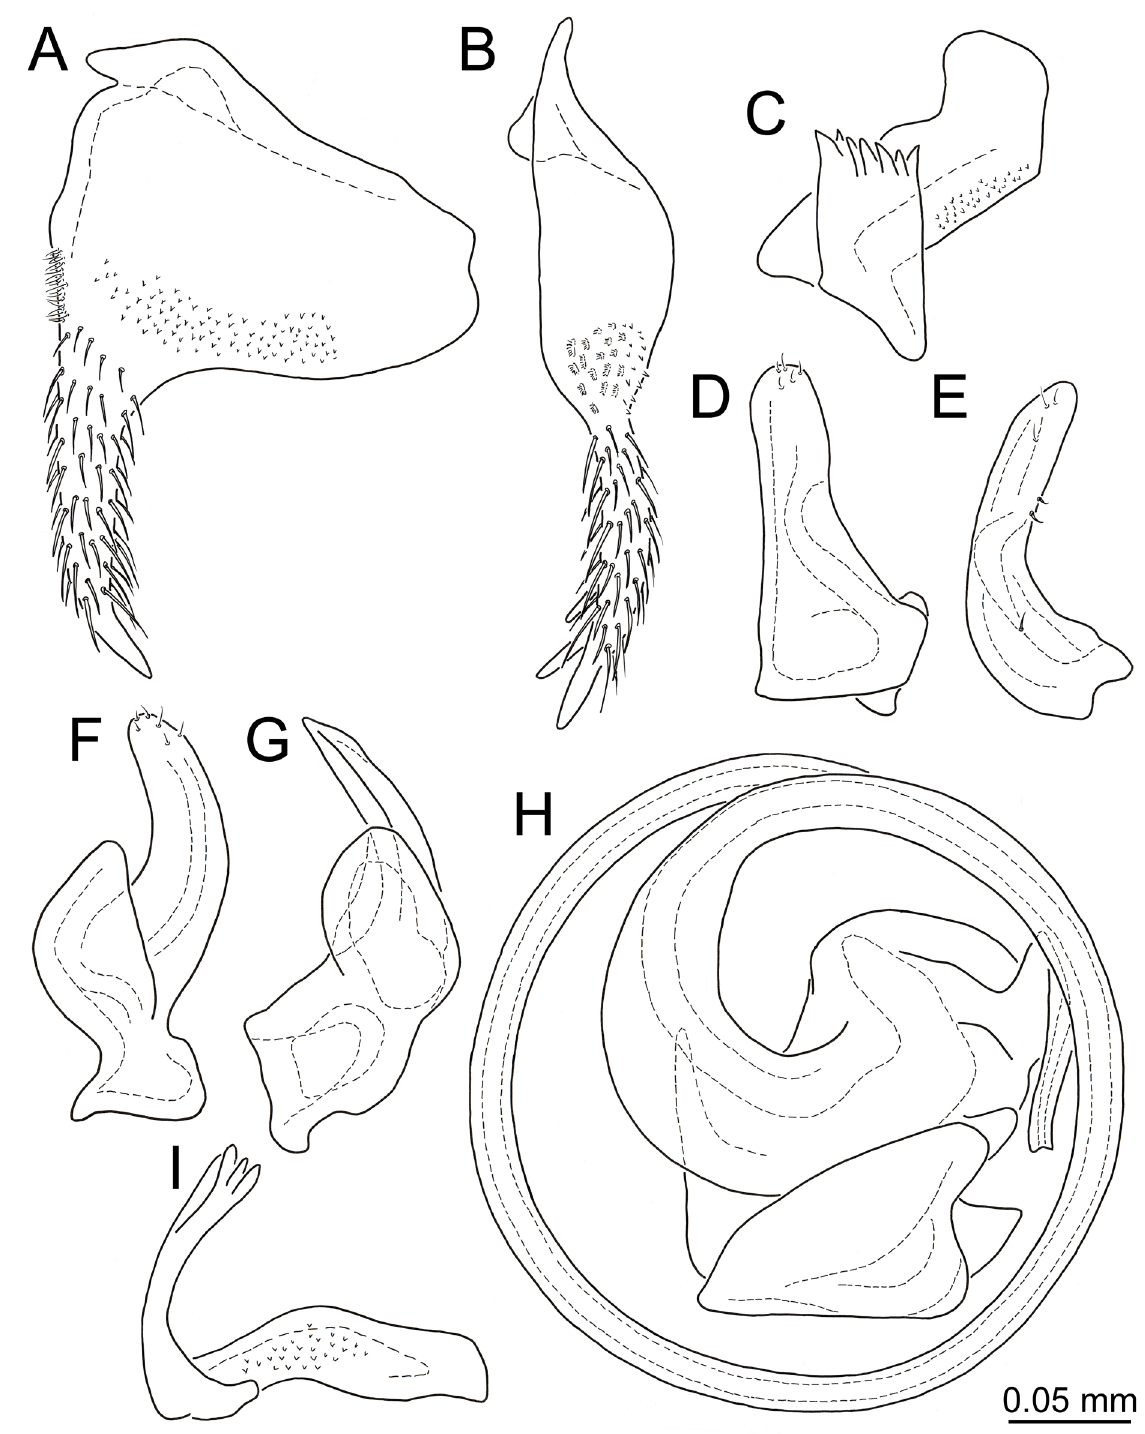
Fig. 4. Kokeshia baii sp. nov., segment VIII and genitalia, paratype, ♂ (SYSBM). A‒B . Left hemitergite VIII. A . Dorsal view. B . Left lateral view. C, I . Right hemitergite VIII, two different aspects. D‒E . Right paramere, two different aspects. F‒G . Left paramere, two different aspects. H .